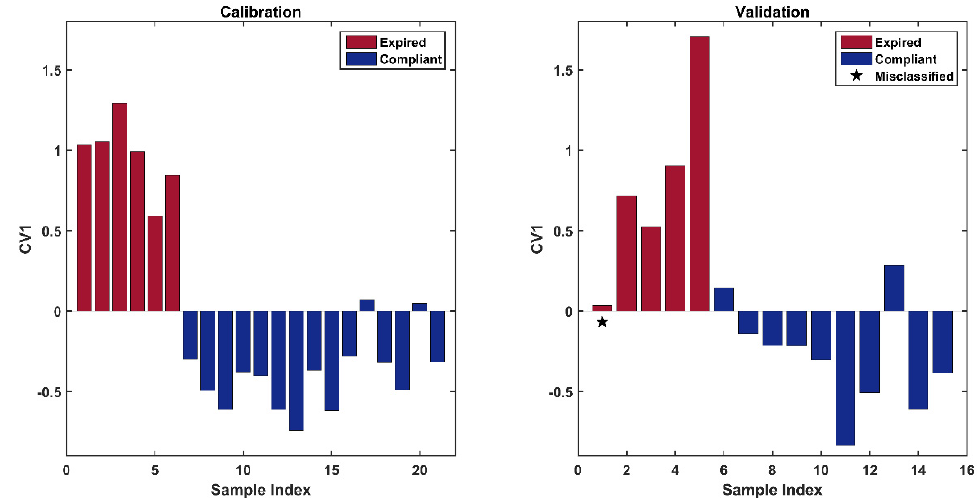
Figure 3. Canonical variate scores of calibration samples ( left plot); canonical variate scores of validation samples ( right plot). The black star indicates the misclassified sample.